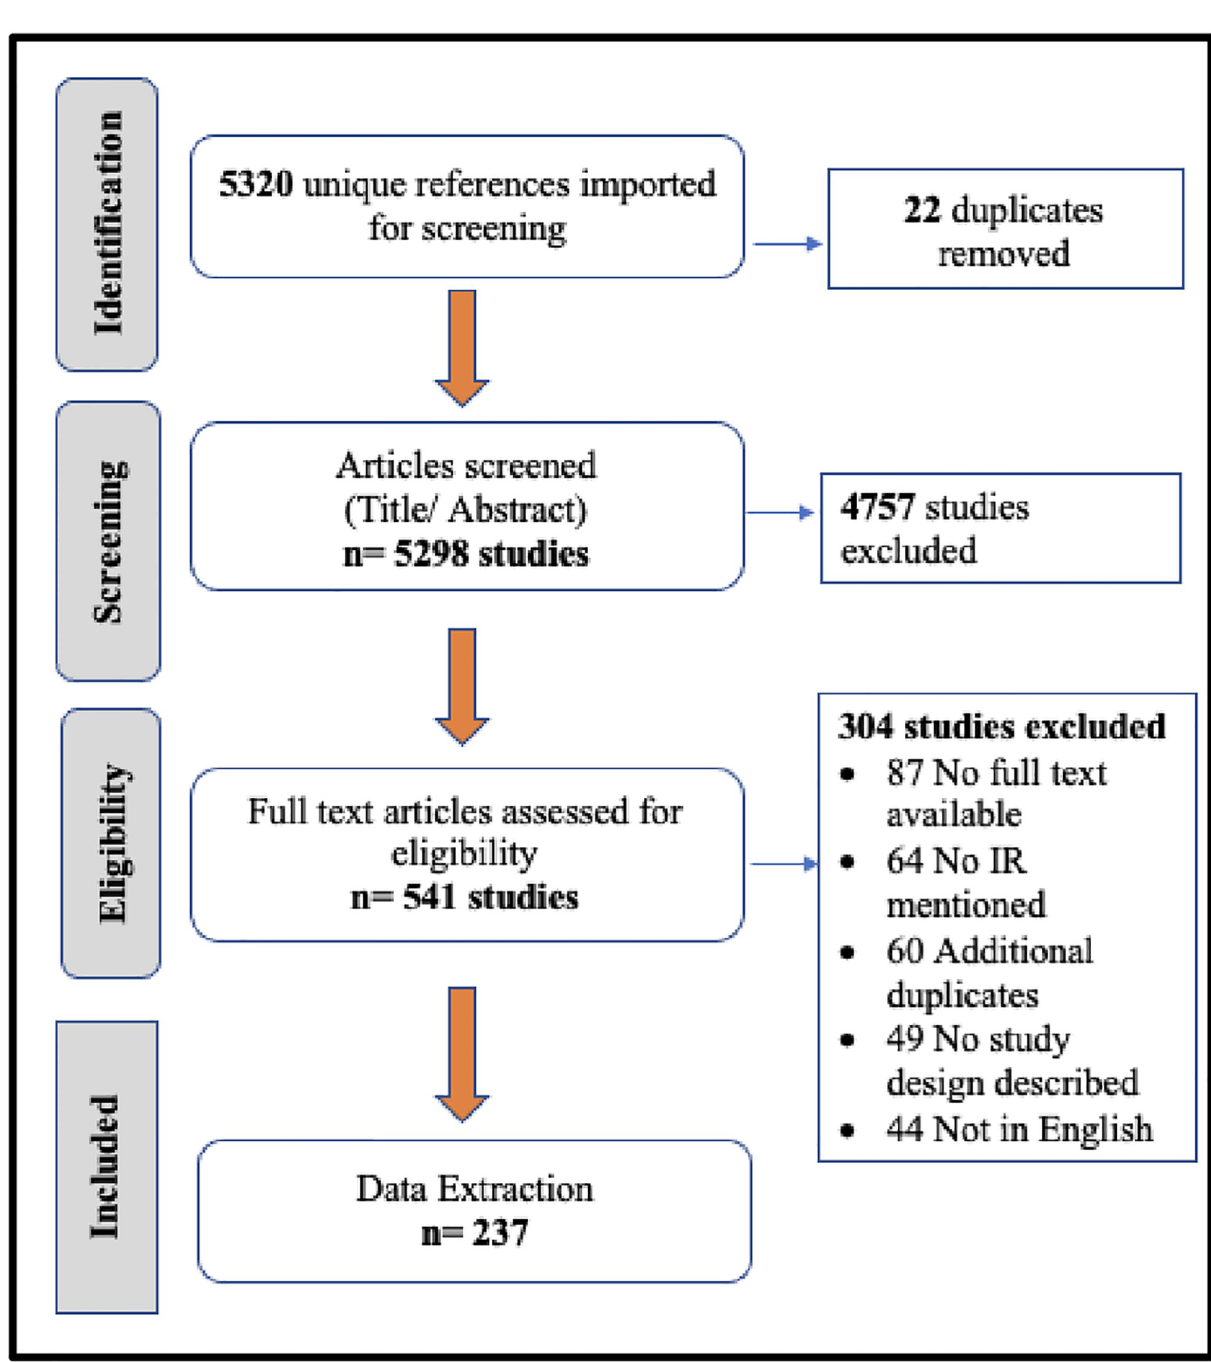
Fig 1. PRISMA flow chart of study selection. (Source: